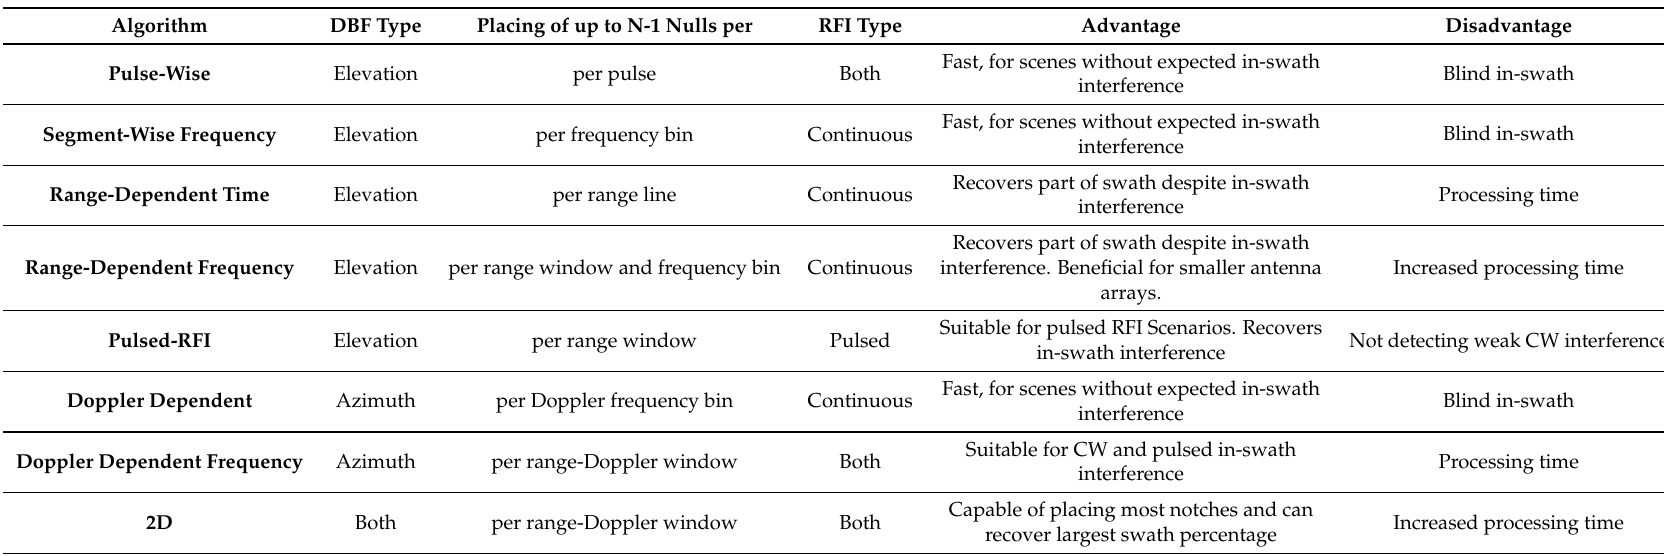
Table 2. Summary of the presented